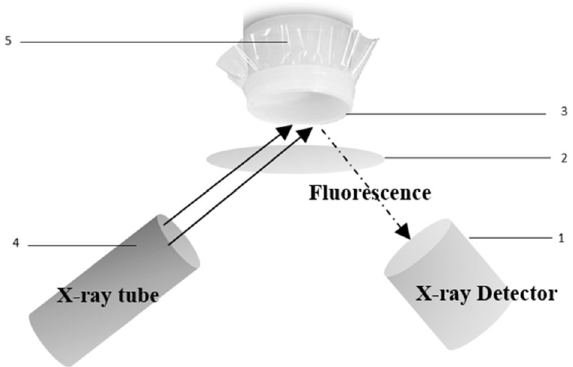
Figure 1. The main components of the XRF setup: (1) detector, (2) protection film, (3) 3.6 µm thick Mylar film, (4) X-ray tube, (5) cup sample holder.